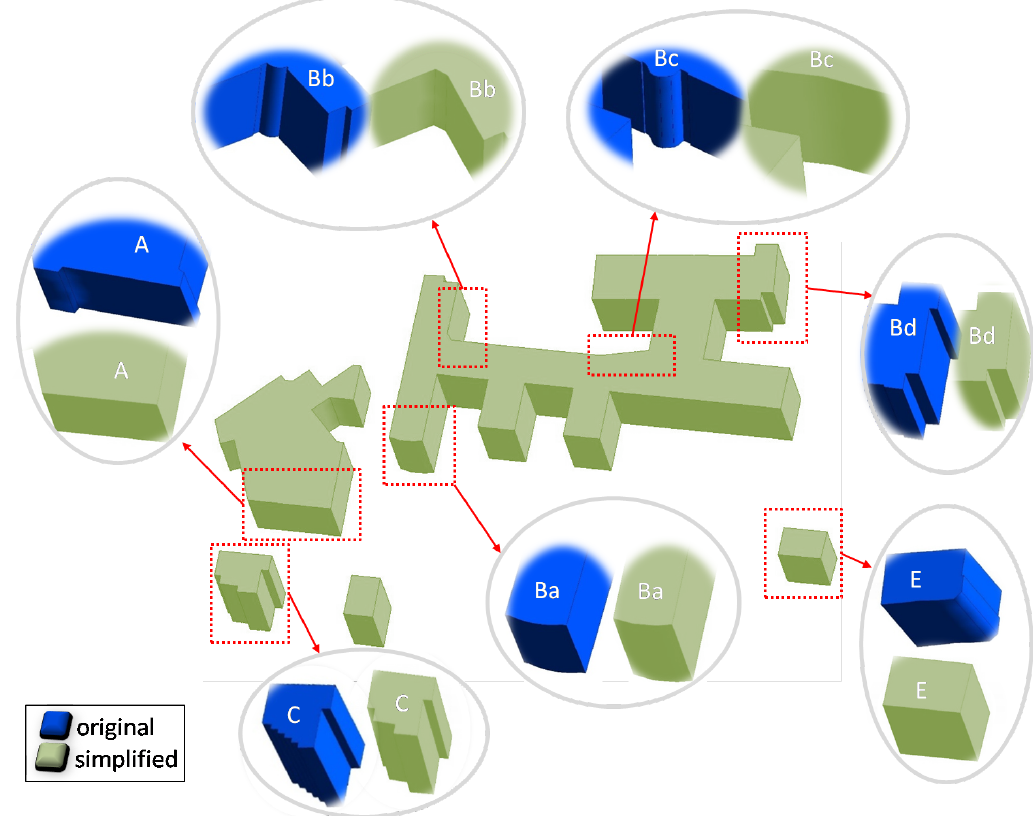
Figure 3. Optimized model of a building block in Stuttgart including details, before (blue) and after optimization